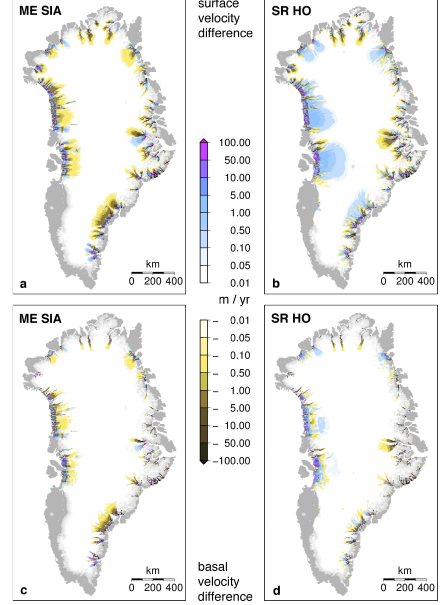
Fig. 6. Differences in ice velocity changes for the 5km MarAsl2 experiment after 50yr for ME SIA (a, c) and SR HO (b, d) . Surface (upper panels) and basal velocity changes (lower panels) are shown with respect to the changes in the DR SIA velocity